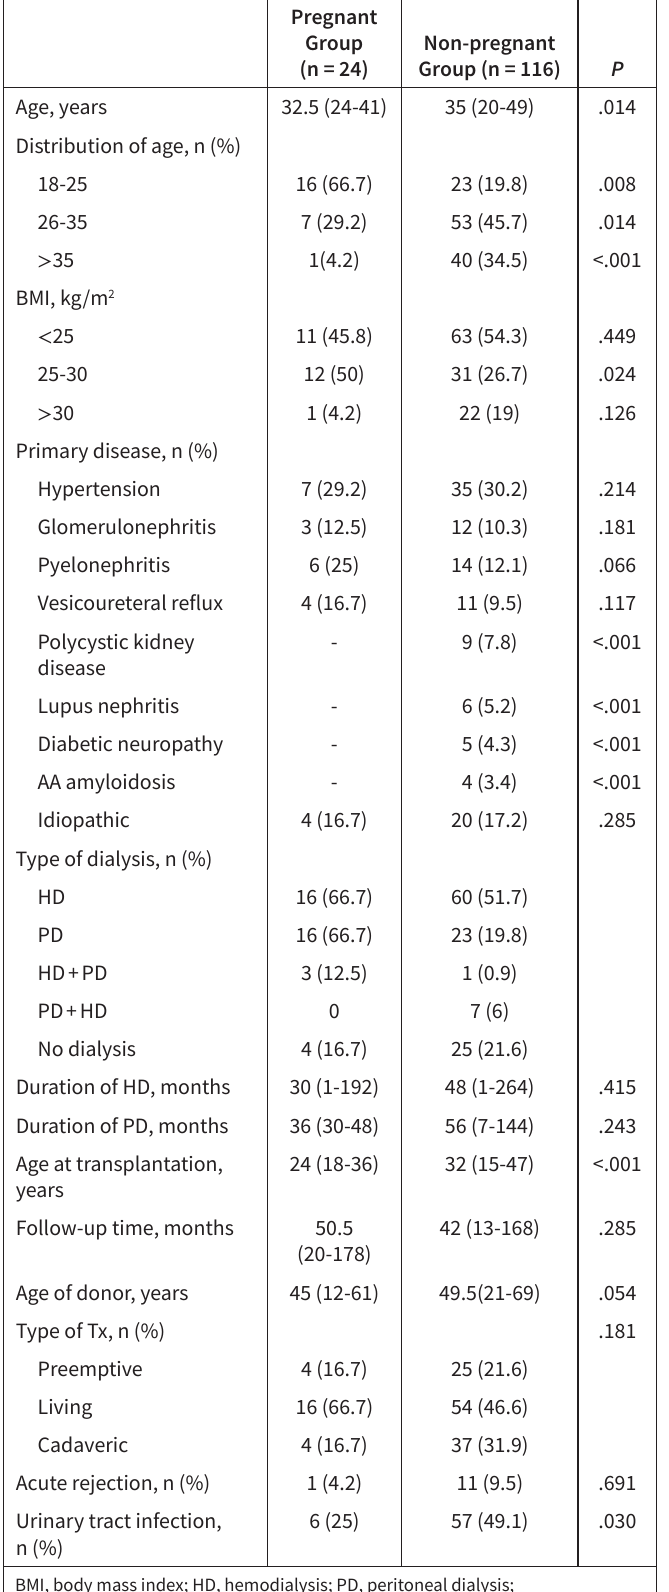
Table 1. Demographic Characteristics of Pregnant